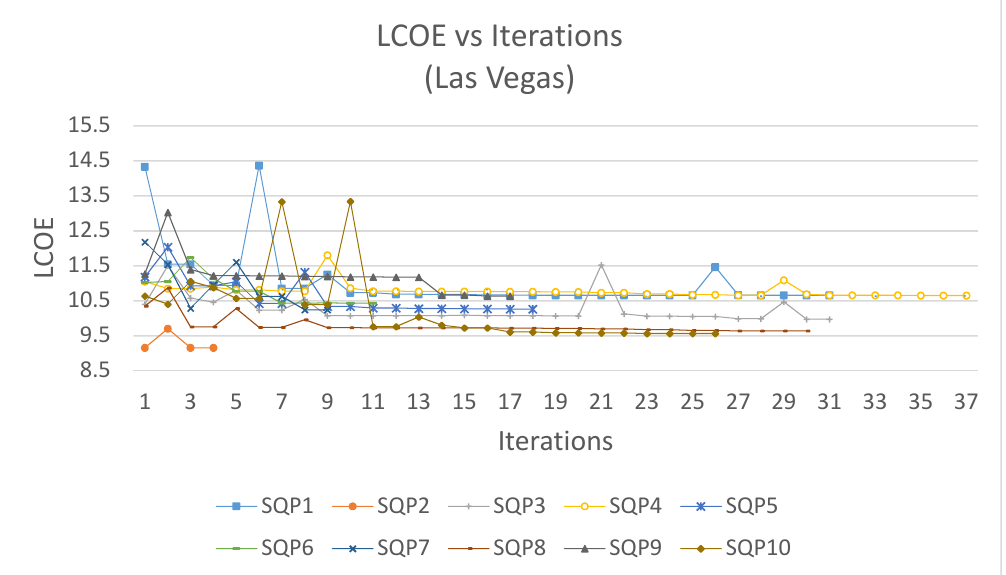
Figure 2. Optimization iteration summary for Las Vegas. Energies 2020 , 13 , x FOR PEER REVIEW